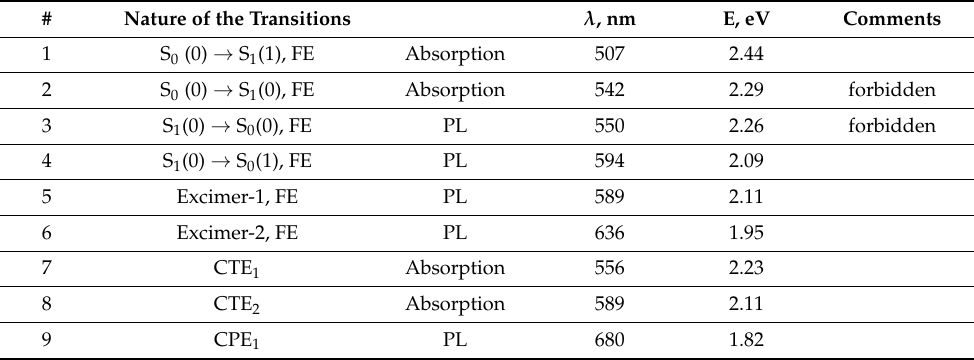
Figure 9. Energy diagram of exciton transitions for 2416SL in the condensed phase and CdTe-2416SL nanoaggregates. More details about each transition are summarized in Table 6. Table 6. Exciton transitions for 2416SL in the condensed phase and CdTe ‐ 2416SL nanoaggregates.